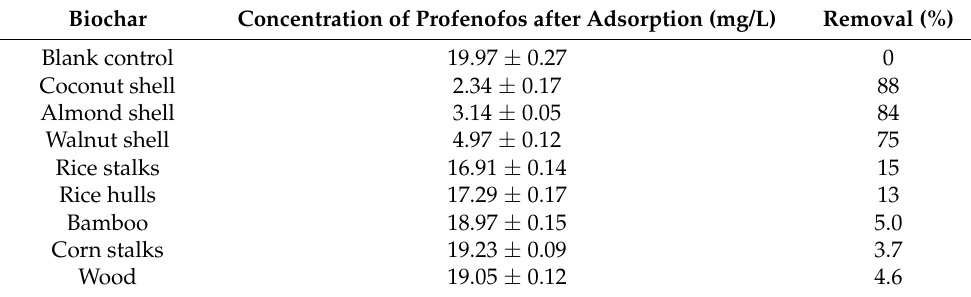
Table 1. Adsorption capacity of biochars for